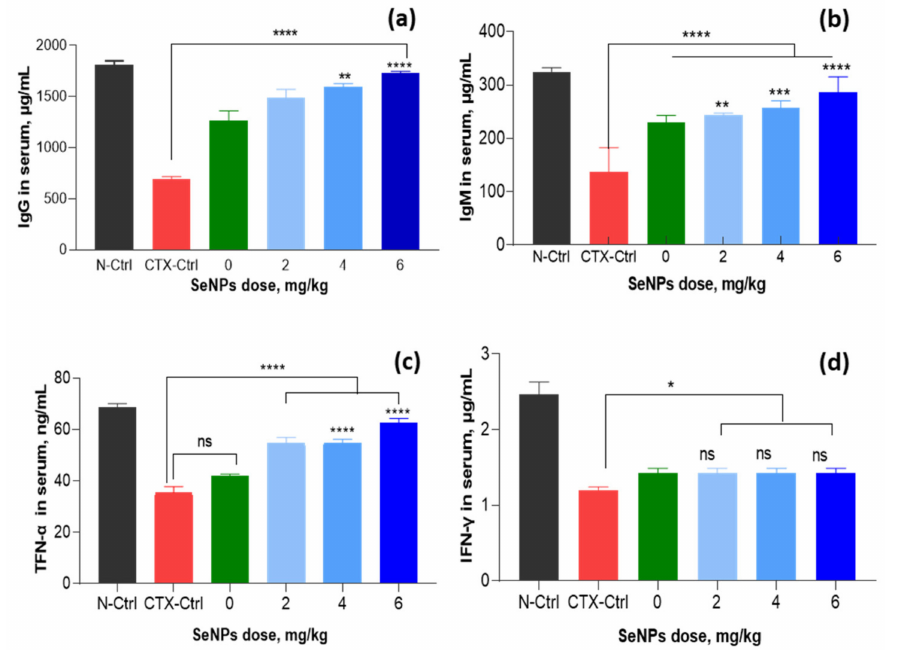
Figure 12. Effect of SeNPs/ β -glucan concentration on humoral immunity factors in serum of CTX- induced immunosuppressed mice. ( a – d ) are IgG, IgM, TFN- α and IFN- γ indexes, respectively; N-Ctrl: Normal control mice received only distilled water; CTX-Ctrl: CTX-induced immunosuppressive mice received only distilled water; in supplemented groups, mice were orally supplied with 0 (only β -glucan without SeNPs), 2, 4 and 6 mg SeNPs kg − 1 . Significant differences were compared with the CTX-Ctrl. ns, not significantly different at p > 0.05; *, significant different at p < 0.05; **, significant different at p = 0.01, *** significant different at p < 0.01; ****, significant different at p < 0.001. Data were statistically analyzed using the ANOVA test and expressed as means ± SD, n =